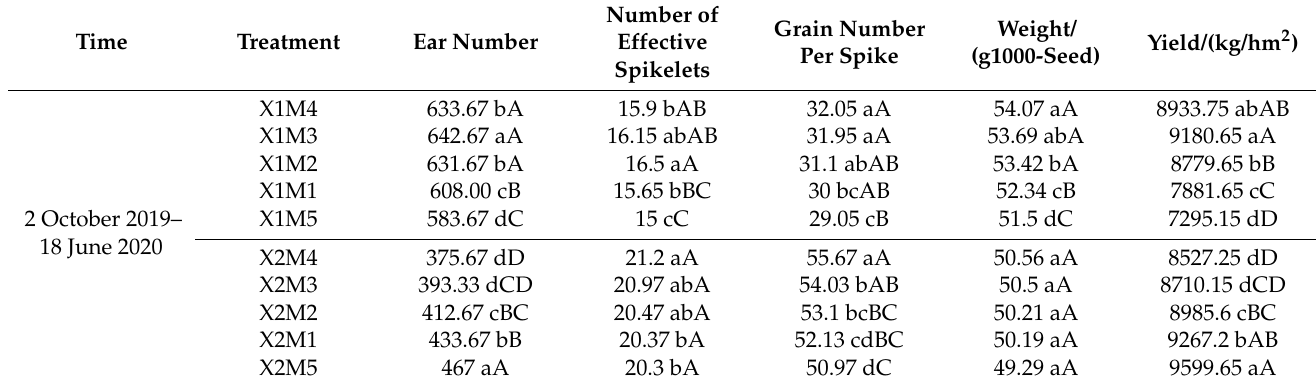
Table 1. Yield measurement data of winter wheat under different plant row configurations.